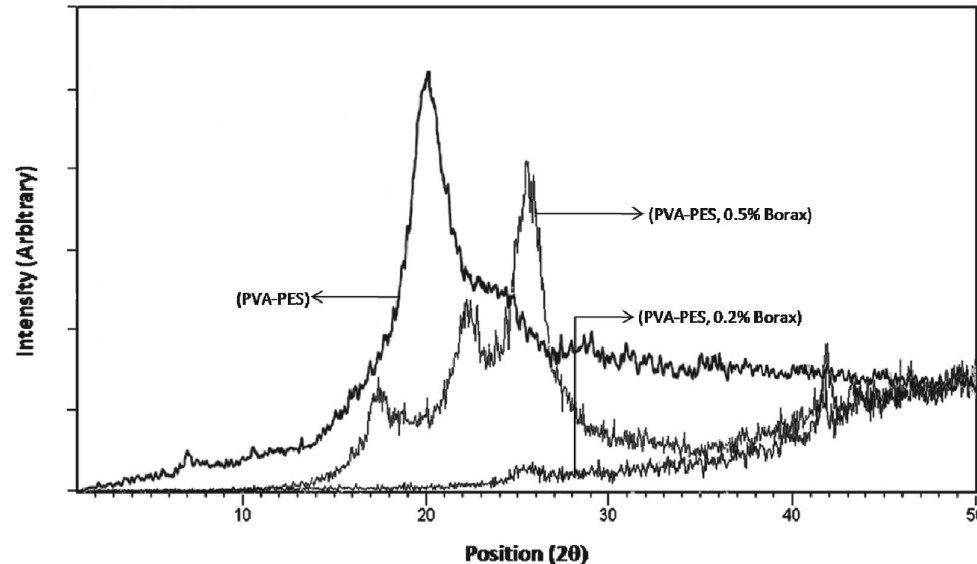
Fig. 5. Wide angle X ray diffraction pattern of the borax cross-linked PVA-PES composites membranes used in the present study with two different borax concentrations viz 0.2% and